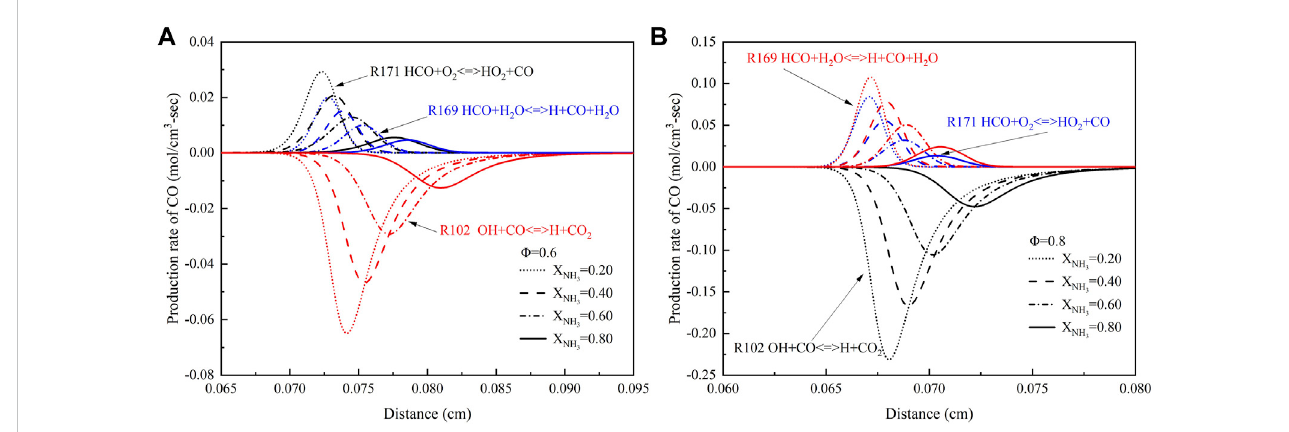
FIGURE 14 The production rate of CO with different ammonia content: (A) Φ = .6; (B) Φ = .8. (T = 723 K, p = 16.5 atm).